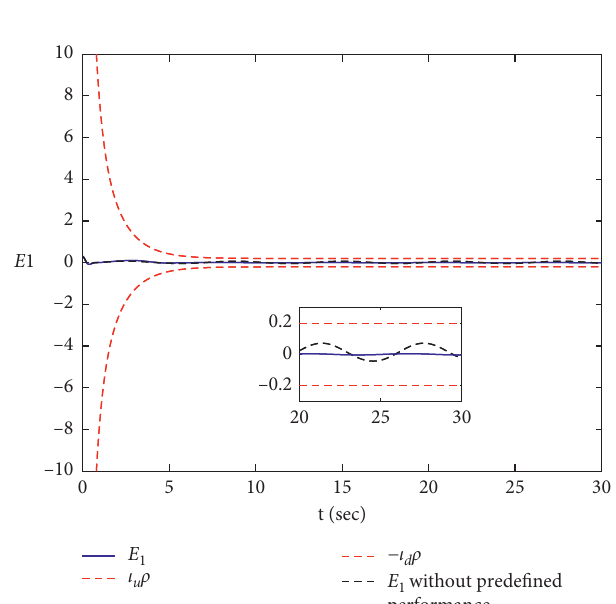
with prescribed performance ι u ρ and 1